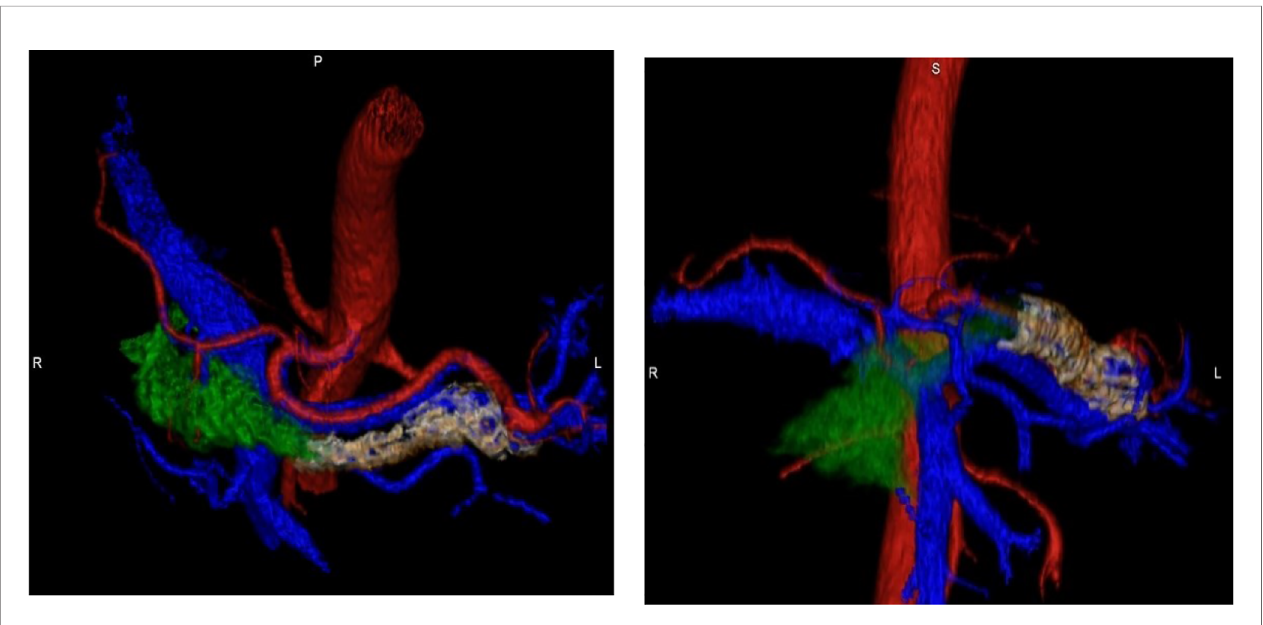
FIGURE 1 | Pancreatic Tumor Volumetric